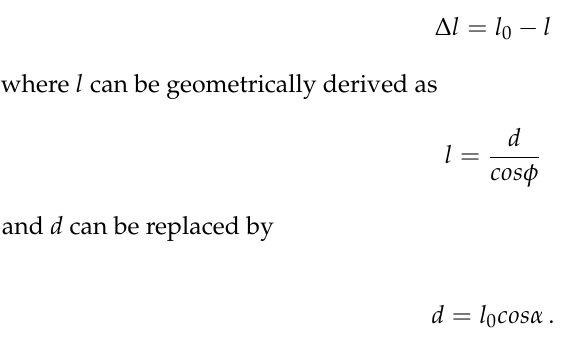
Figure 1. Von Mises elastic